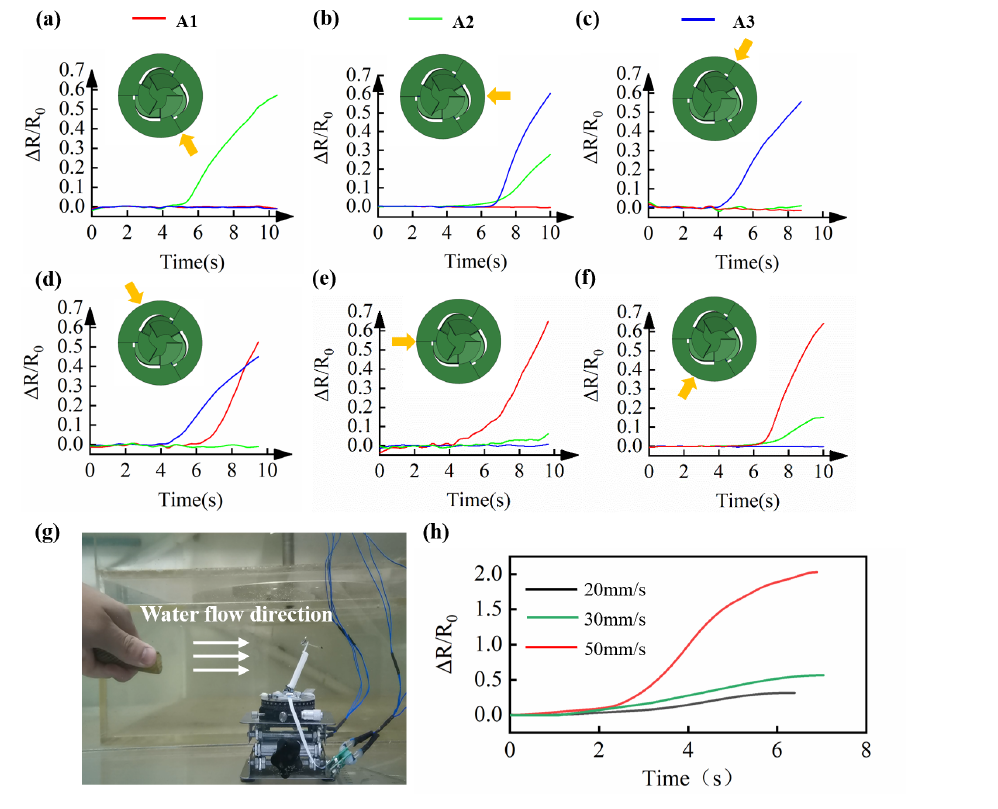
Figure 7. Loading direction and velocity sensing capability of the miniature soft sensor. ( a – f ) The miniature soft sensor perception of external load in different directions. Yellow arrows indicate the direction of the load. ( g ) Experimental setup of the water flow perception experiment. ( h ) Sensor signal under different water flow